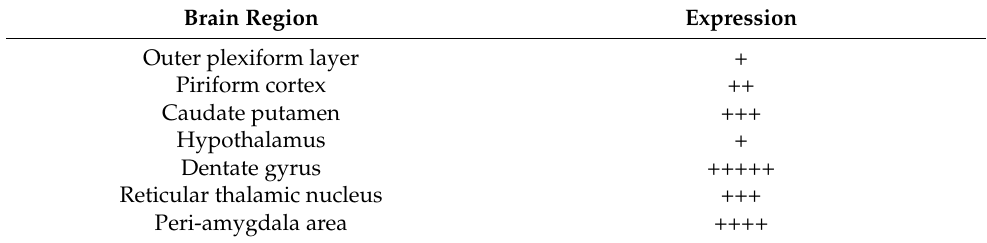
Table 1. GFP expression in various brain regions of the TWIK-1 BAC-GFP Tg mice. Brain